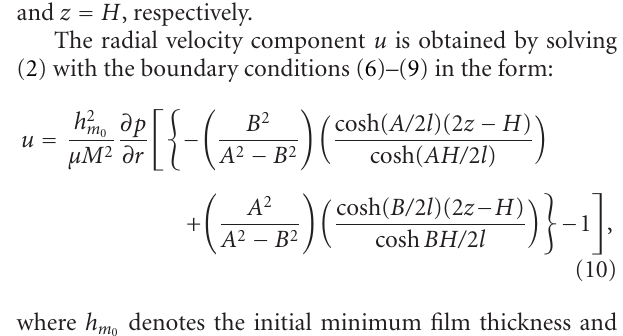
and the magnetohydrodynamic (MHD) momentum equa- tions in polar coordinates ( r , θ , z )